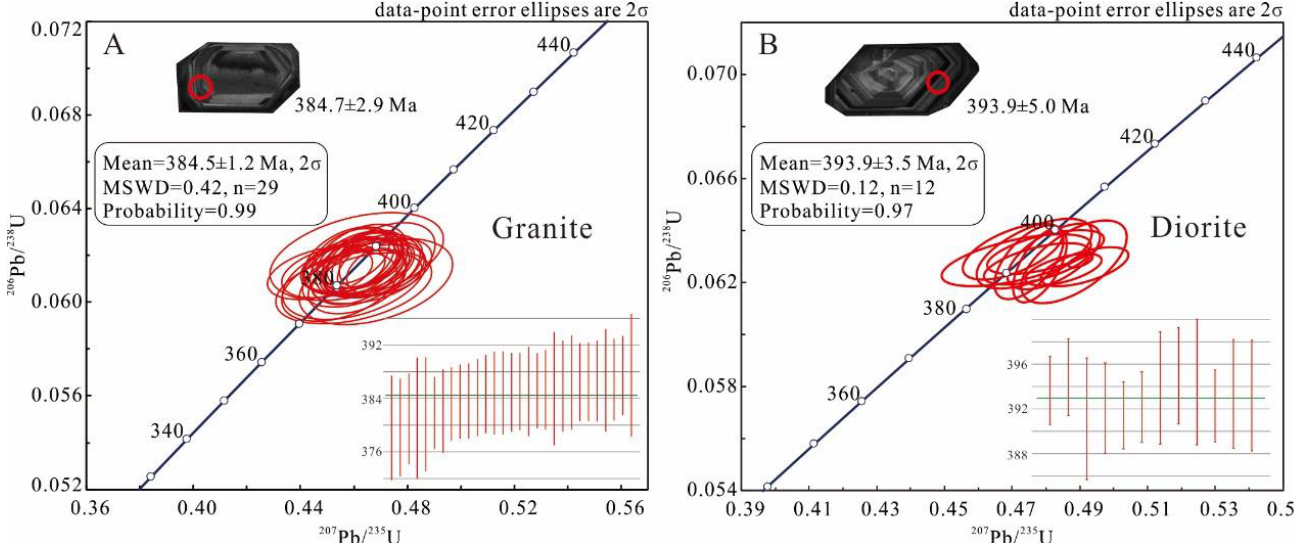
Figure 5. Zircon U – Pb age diagrams of granite and diorite from the Jinba gold deposit. ( A ) Zircon Figure 5. Zircon U–Pb age diagrams of granite and diorite from the Jinba gold deposit. ( A ) U – Pb age of granitic dykes; ( B ) Zircon U – Pb age of diorite dykes.